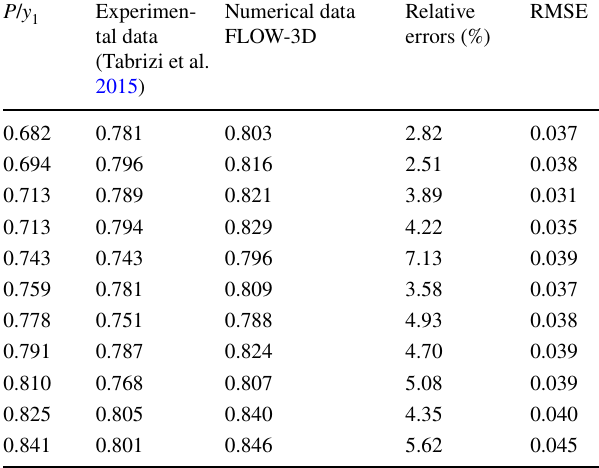
Fig. 3 Comparison of numerical and experimental discharge coeffi- cients ( P = 40 cm, L / B = 0.667, Z = 1) Table 3 Comparison of numerical and experimental discharge